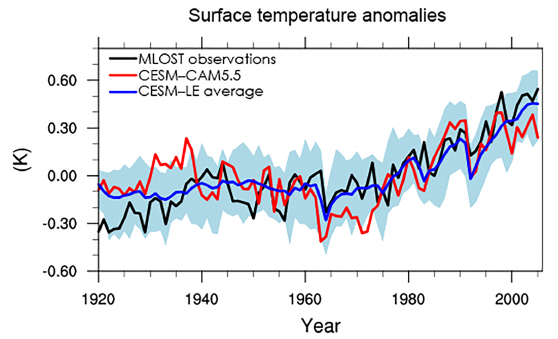
Figure 15. Evolution of the globally averaged surface temperature for the 1920–2005 period of the historical run for the Merged Land– Ocean Surface Temperature Analysis (MLOST) observations (black curve), CCSM4 ensemble average (green curve), CESM large en- semble average (blue curve), and CESM-CAM5.5 (red curve). The blue shading denotes the CESM large ensemble spread.